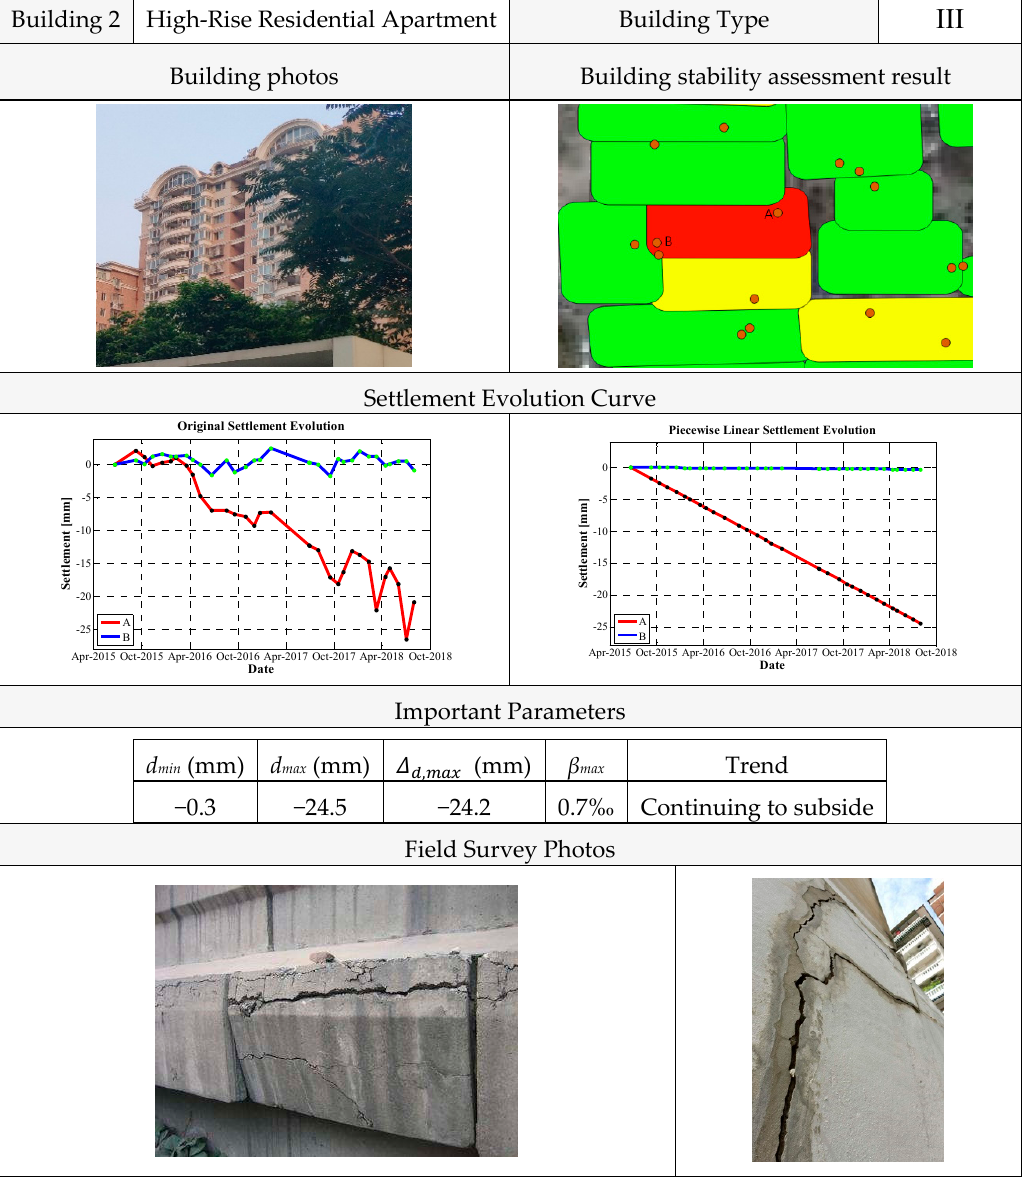
Figure 18. Example of analysis results: Building 2.